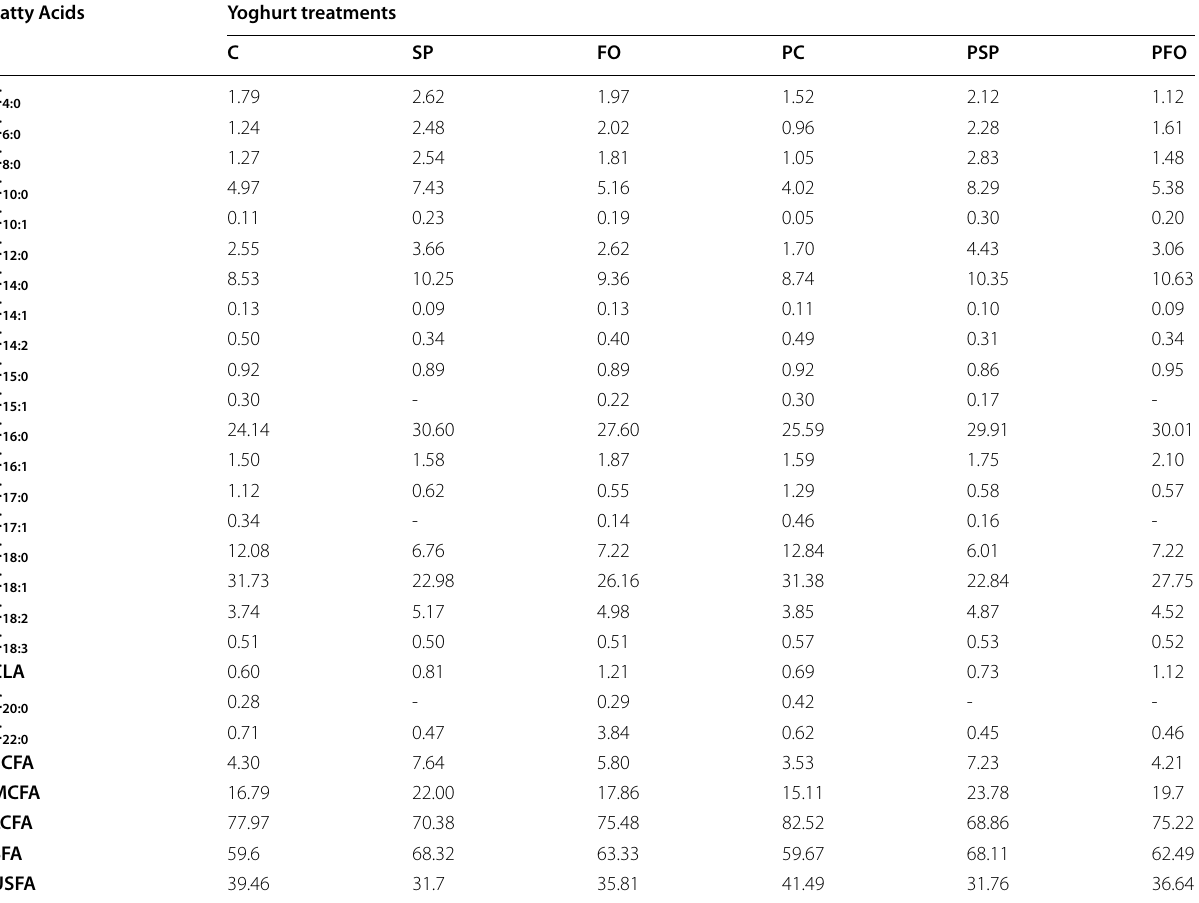
Table 3 Fatty acids profile of probiotic and non‑probiotic yoghurts made from ewes’ milk fed a diet supplemented with Spirulina platensis or fish